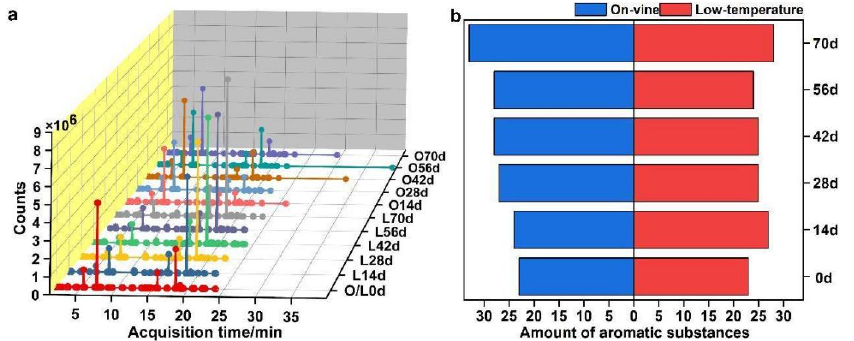
Figure 5. Quantitative analysis of aroma compounds. ( a ) Total ion current flow diagrammatic sketch of aroma substances. ( b ) Quantity of aroma substances under different softening methods in each period.